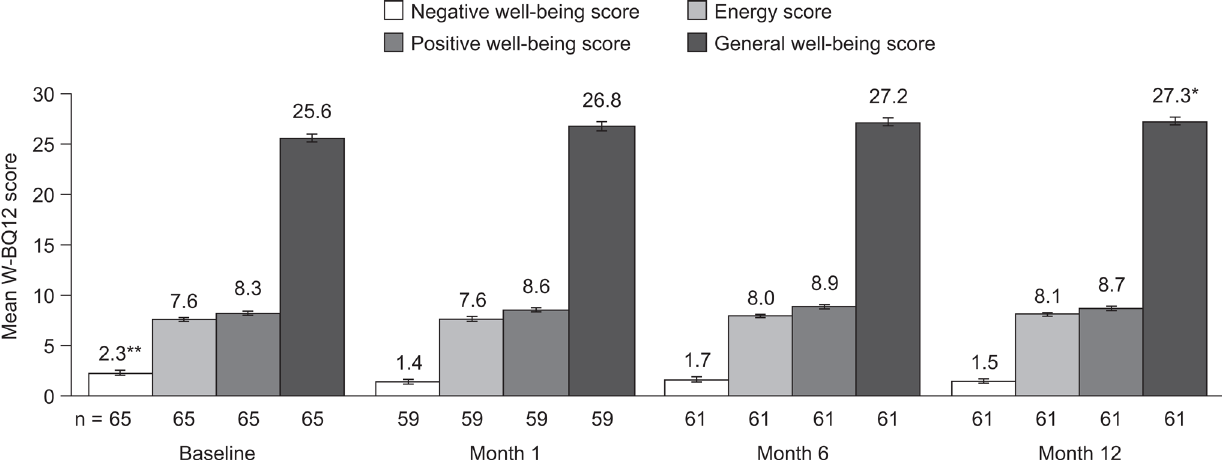
Fig 3. Mean W-BQ12 negative well-being, energy, positive well-being and general well-being scores. Data are shown as mean ± standard error. * p < 0.05 vs baseline. ** p < 0.01 vs baseline. W-BQ12, 12-item Well-Being